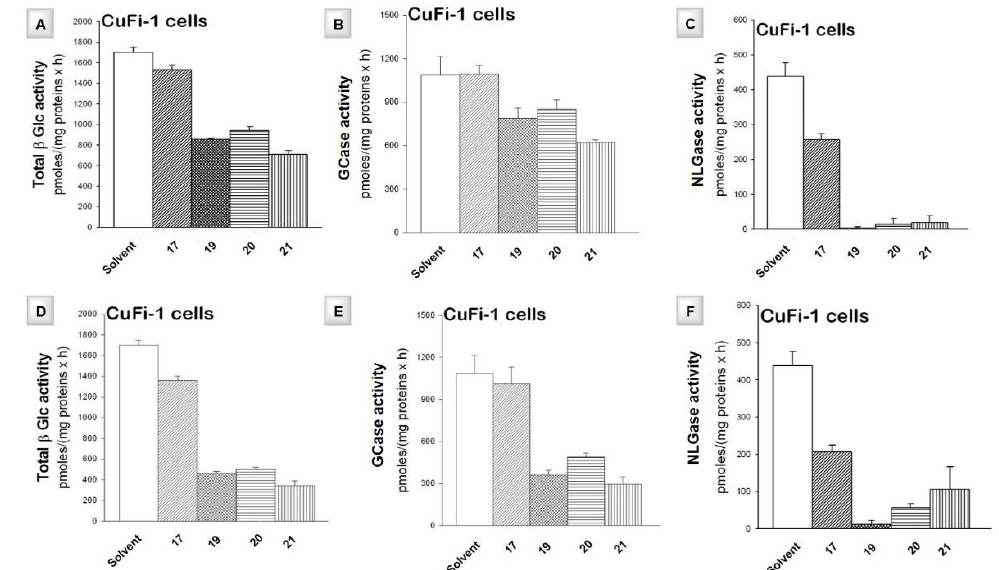
Figure 21. E ff ect of AMP-DNM derivatives on β -glucosidase activity in CF bronchial cells. CuFi-1 cells Figure 21. Effect of AMP-DNM derivatives on β-glucosidase activity in CF bronchial cells. CuFi-1 cells were treated with ( A – C ) 0.5 µ M or ( D – F ) 5.0 µ M of compound for 1 h before the measurement (adapted were treated with ( A – C ) 0.5 μM or ( D – F ) 5.0 μM of compound for 1 h before the measurement from [176]). (adapted from [176]). Int. J. Mol. Sci. 2020 , 21 , x FOR PEER REVIEW